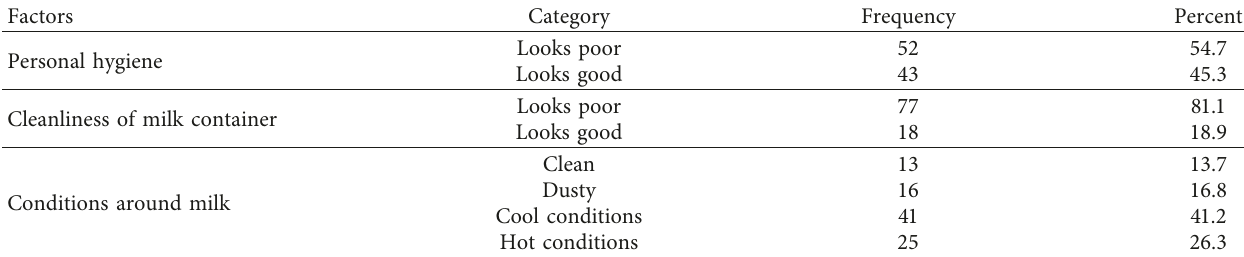
Table 3: Observational findings among Borena zone Gomole District, South Ethiopia, 2019.